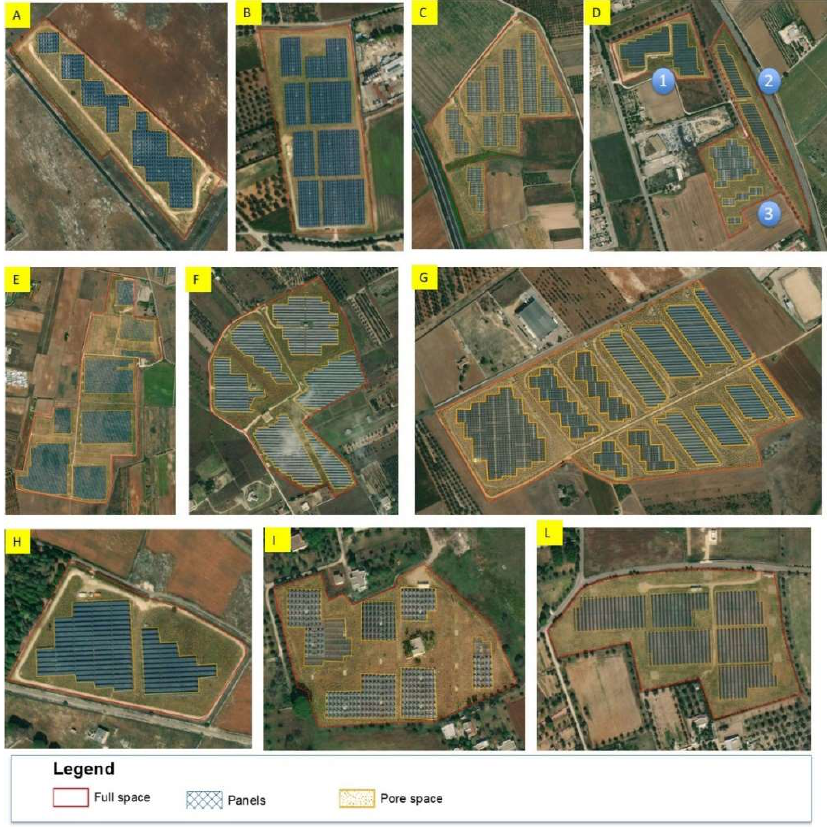
Figure 4. Characterisation of pore spaces in some GPV systems ( A – L ) located in the Apulia region (southern Italy), in the provinces of Brindisi and Lecce. Please see Table 2 for the description of the systems.